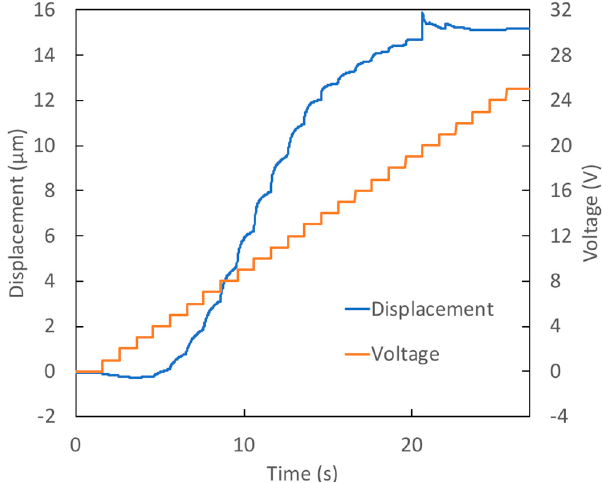
Figure 3. Test 1—Response of prototype with a thin (39 μ m), large diameter (510 μ m) membrane to staircase voltage signal.